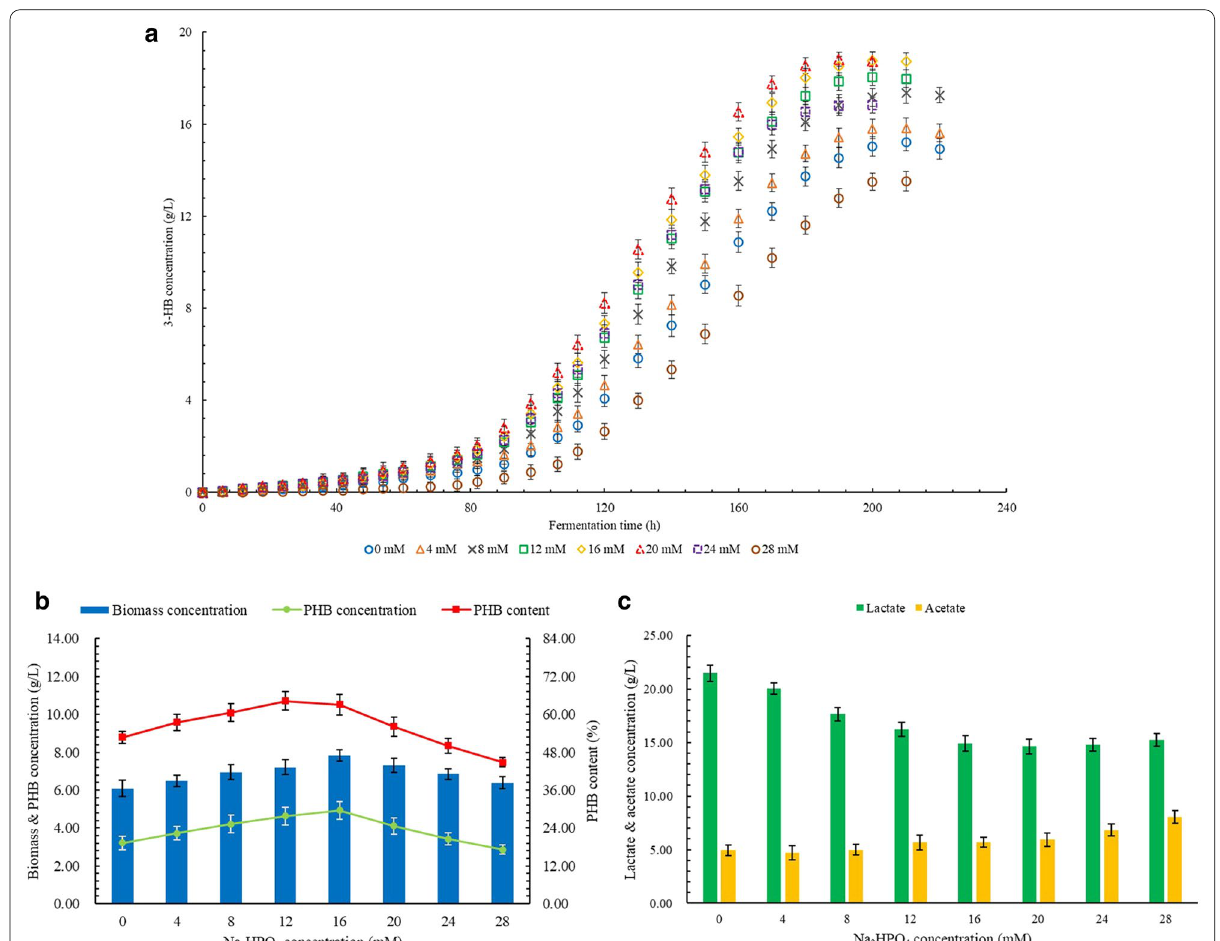
Fig. 3 a Effects of Na2HPO4 on the production of 3-HB. b Effects of Na2HPO4 on the production of PHB. c Effects of Na2HPO4 on the production of LA and AC